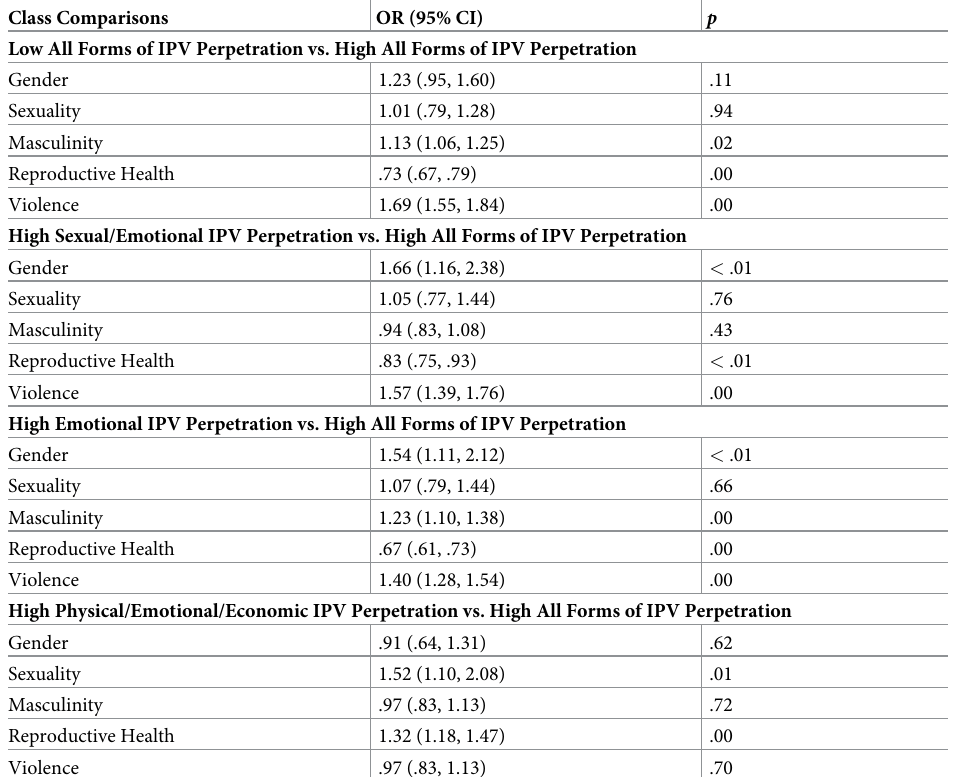
a Covariates include age, education, employment, married/cohabitating, whether they had kids and accounted for multistage clustering. b Low All Forms of IPV Perpetration (n = 6,371); High Sexual/Emotional IPV Perpetration (n = 863); High Emotional IPV Perpetration (n = 1,337); High Physical/Emotional/Economic IPV Perpetration (n = 719); and High All Forms of IPV Perpetration (n =